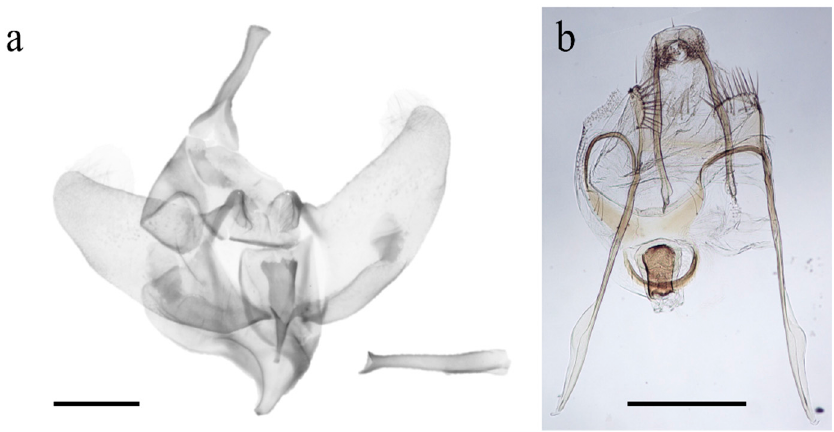
Figure 3. Genitalia of Givira ethela . ( a ) Complete male genitalia and aedeagus; ( b ) Female genitalia. Scale bar = 1.0 mm.